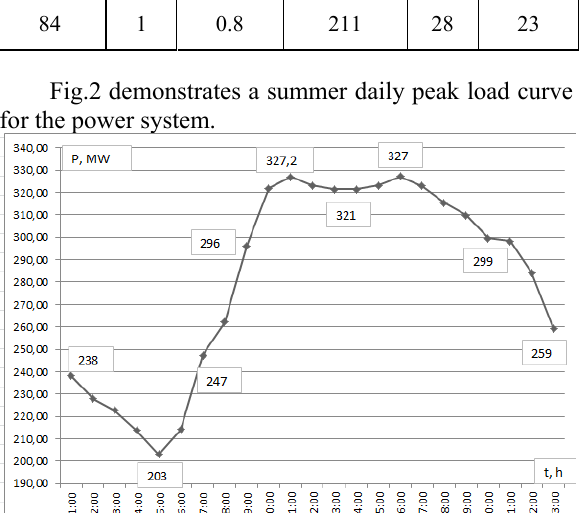
Fig. 2. S ummer daily peak load curve in the power